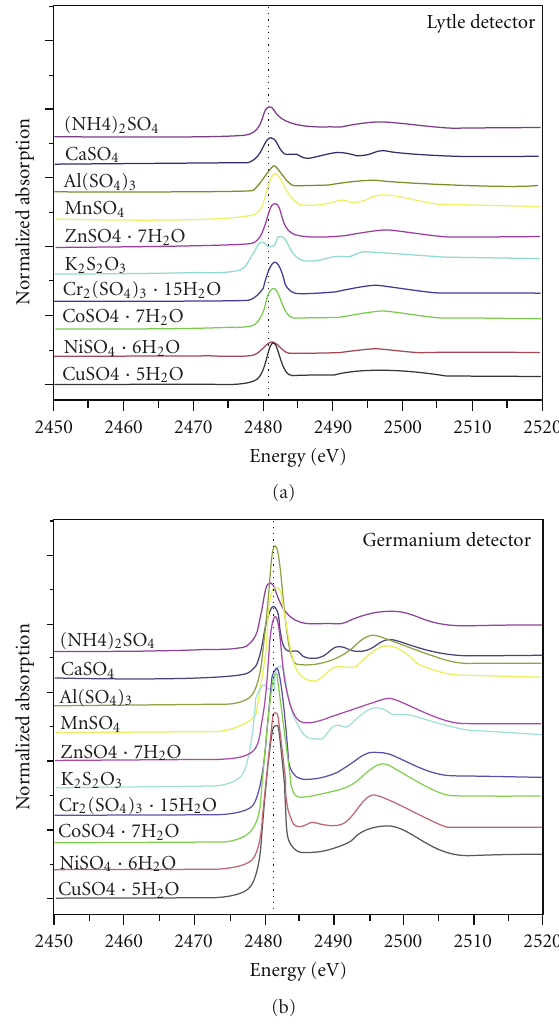
Figure 1: Normalized XANES spectra at sulfur K-edge spec- tra for (NH 4 ) 2 SO 4 , CaSO 4 , Al(SO 4 ) 3 , MnSO 4 , ZnSO 4 ∗ 7H 2 O, K 2 S 2 O 3 , Cr 2 (SO 4 ) 3 ∗ 15H 2 O, CoSO 4 ∗ 7H 2 O, NiSO 4 ∗ 6H 2 O, and CuSO 4 ∗ 5H 2 O measured by Germanium and Lytle detectors. MnSO 4 , ZnSO 4 · 7H 2 O, Cr 2 (SO 4 ) 3 · 15H 2 O, CoSO 4 · 7H 2 O, NiSO 4 · 6H 2 O, and CuSO 4 · 5H 2 O, the K 2 S 2 O 3 was